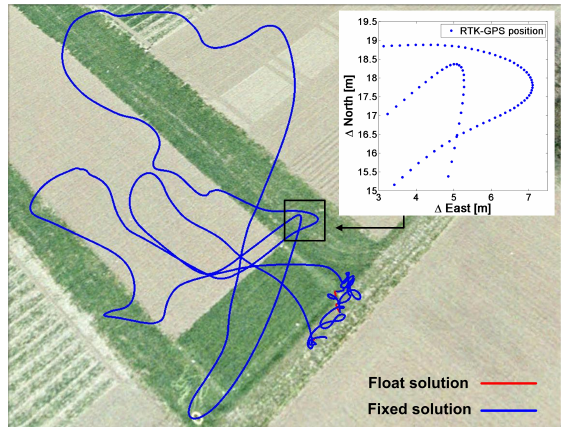
Figure 6: The RTK-GPS positions that were determined during the test flight. The red points are float solutions (real valued ambi- guities), the blue points are fixed solutions (integer